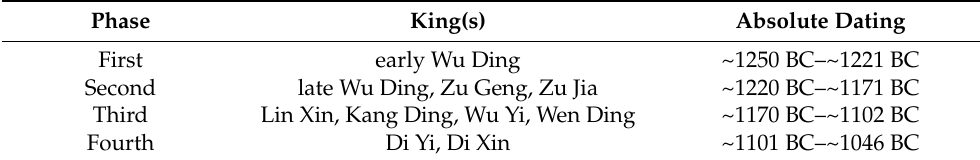
Table 1. Cultural phase division of Yinxu.